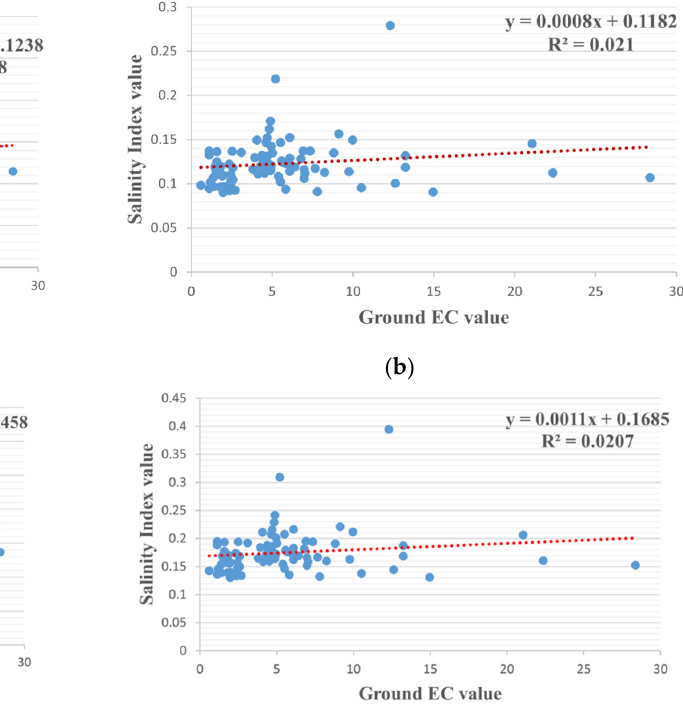
Table 5. Linear regression analysis results for nine different salinity indices.